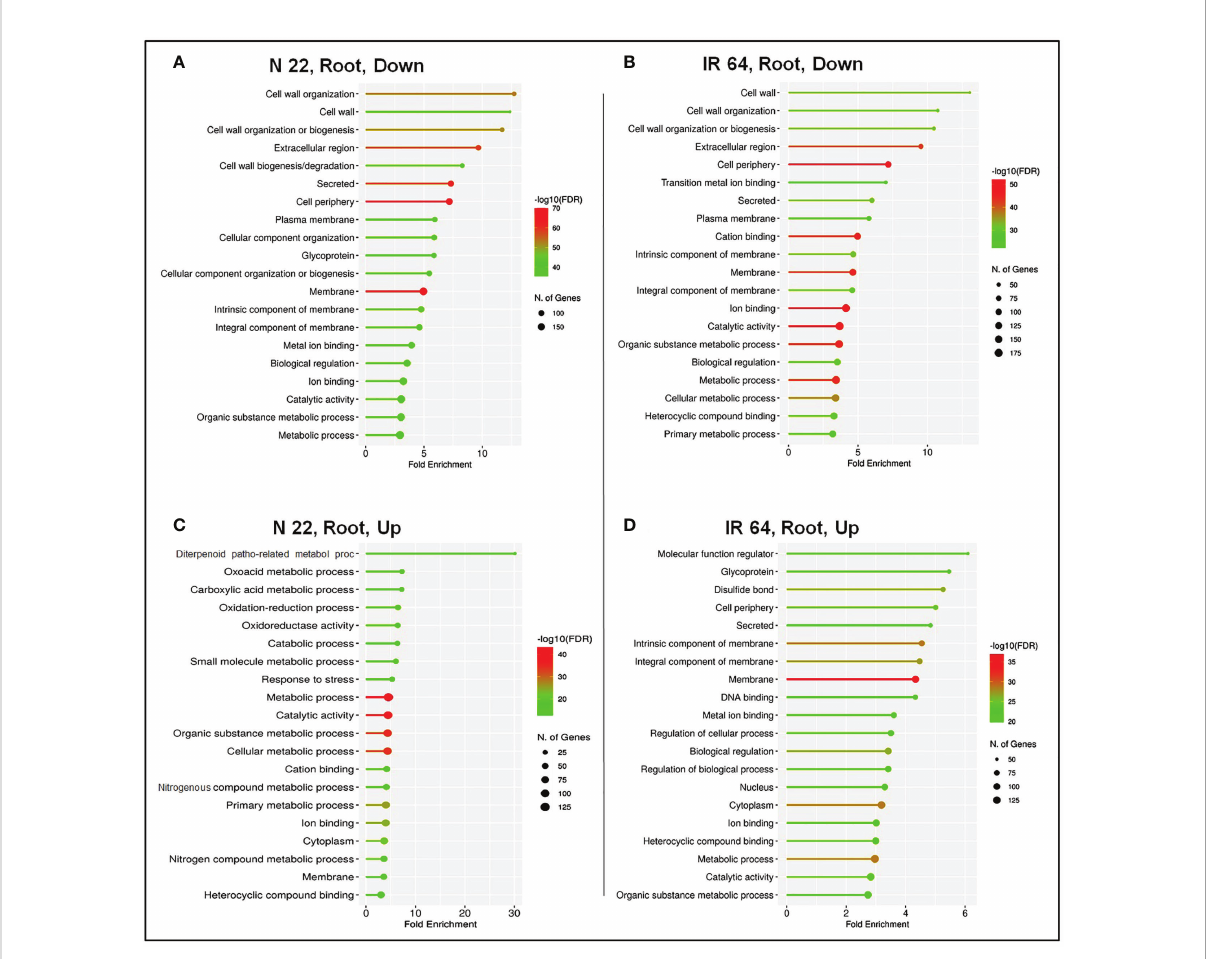
FIGURE 7 Pathway enrichment analysis on direct-sowing imposed with drought stress in root of rice cultivars. (A) Under-represented process/pathway in the root of N 22, (B) under-represented process/pathway in IR 64 root, (C) over-represented process/pathway in N 22 root, and (D) over- represented process/pathway in the root of IR 64. Y-axis shows the name of the process/pathway, and the X-axis shows fold enrichment. Dot- size represents the number of genes and the color indicates the FDR